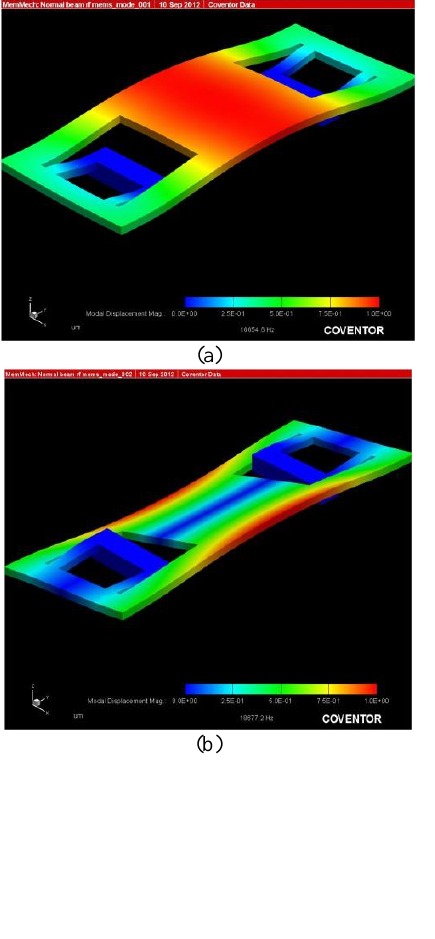
Figure 6 The first three natural frequency of the beam for the mass and k of 2.2×10 -10 Kg and 24 N/m, respectively. (a) First mode natural frequency is 52567 Hz. (b) Second mode natural frequency is 58952 Hz. (c) Third mode natural frequency is 98148 Hz. (52567 Hz) while the other modes does not provide